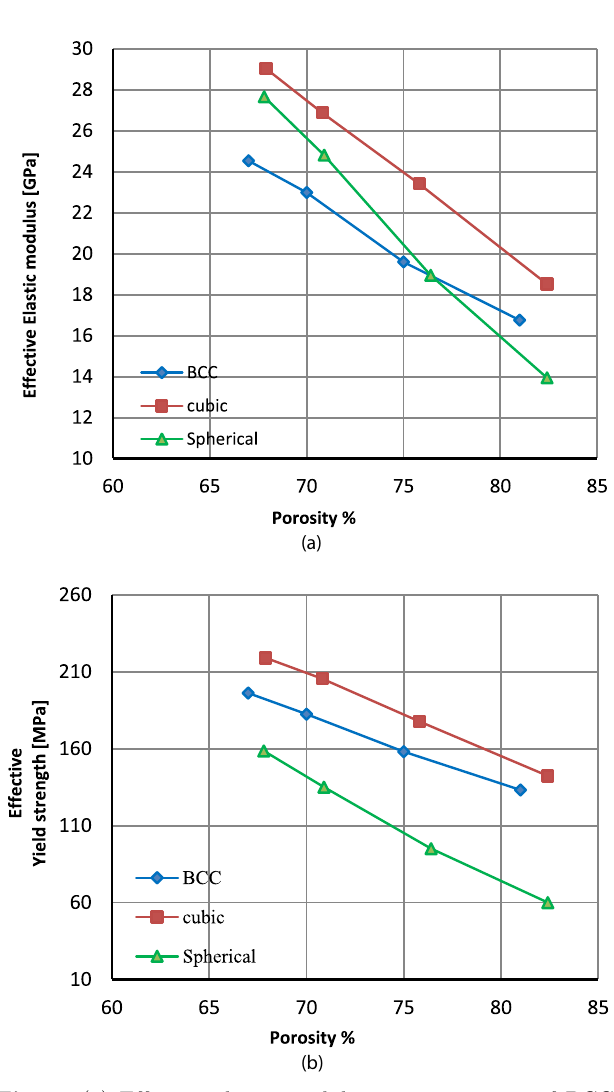
Fig. 8. (a) Effective elastic modulus-porosity curves of BCC, Cubic, and Spherical porous structures of four different porosities, (b) effective yield strength (cid:3) porosity curves of BCC, Cubic, and Spherical porous structures of four different